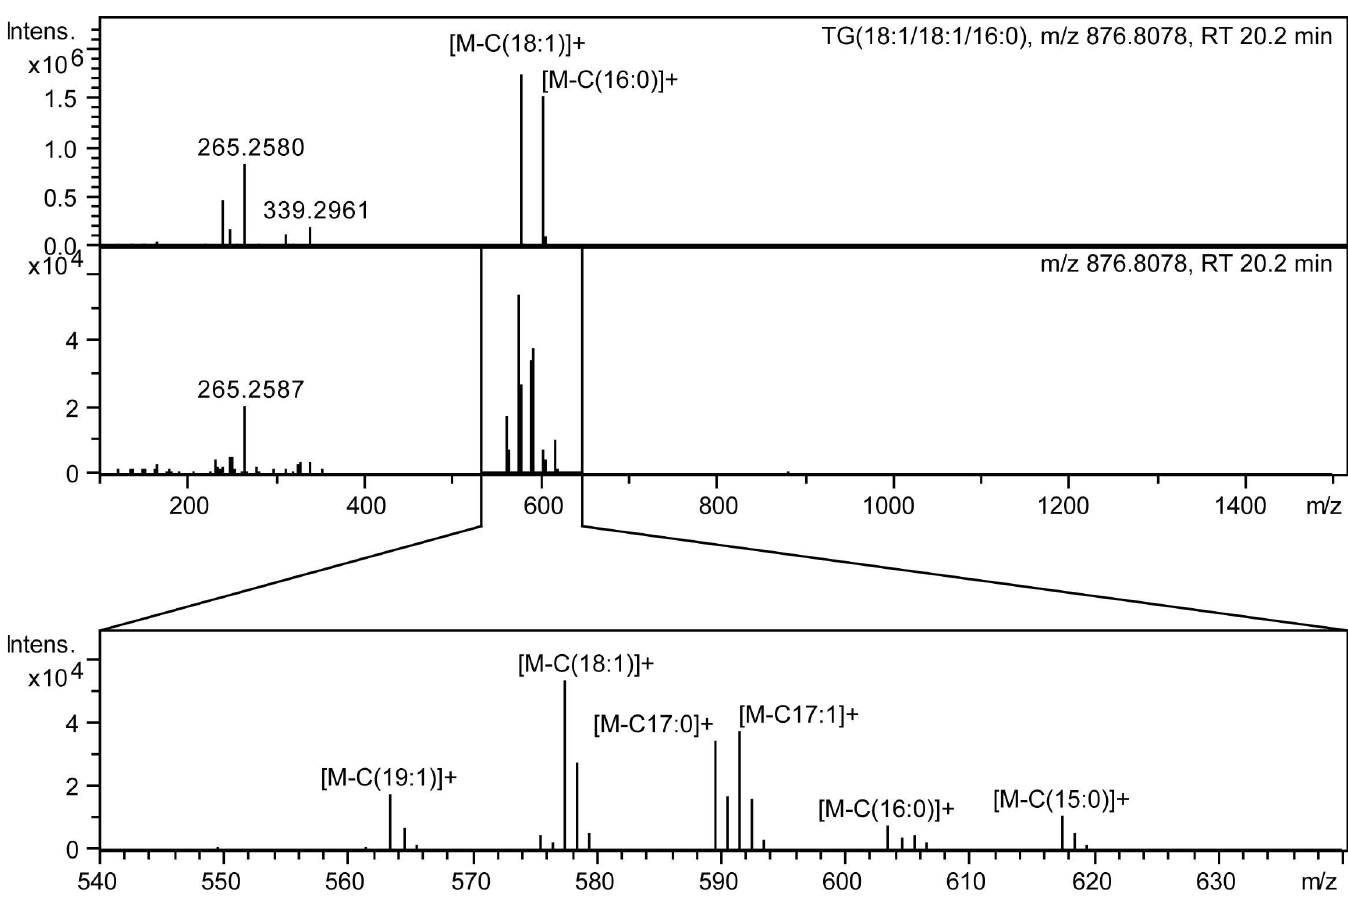
Fig 3. Example of co-elution and overlapping of different TG species in C . elegans . Analysis of spectra derived from TGs is complicated in real samples due to overlap of severalisomeric and isobaricspecies. The upper panel shows the MS/MS spectrum of TG(18:1/18:1/16:0) standard and the lower of the same chromatographic peak in a C . elegans lipid